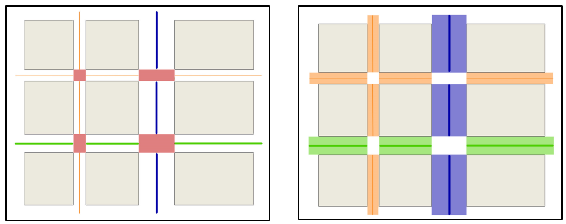
Figure 7. [Left] In red: intersections considered as car traffic space. [Right] In orange, green and blue the effective space for calculations. The colour indicates the typology of the roads.